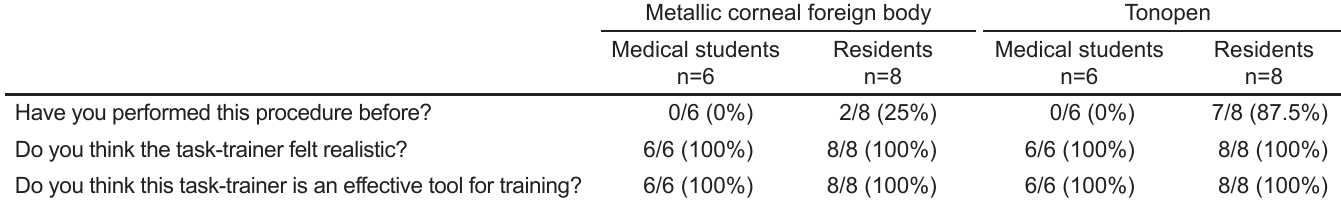
Table. Pilot study survey results: Survey results obtained for task-trainer after completion of metallic corneal foreign body removal